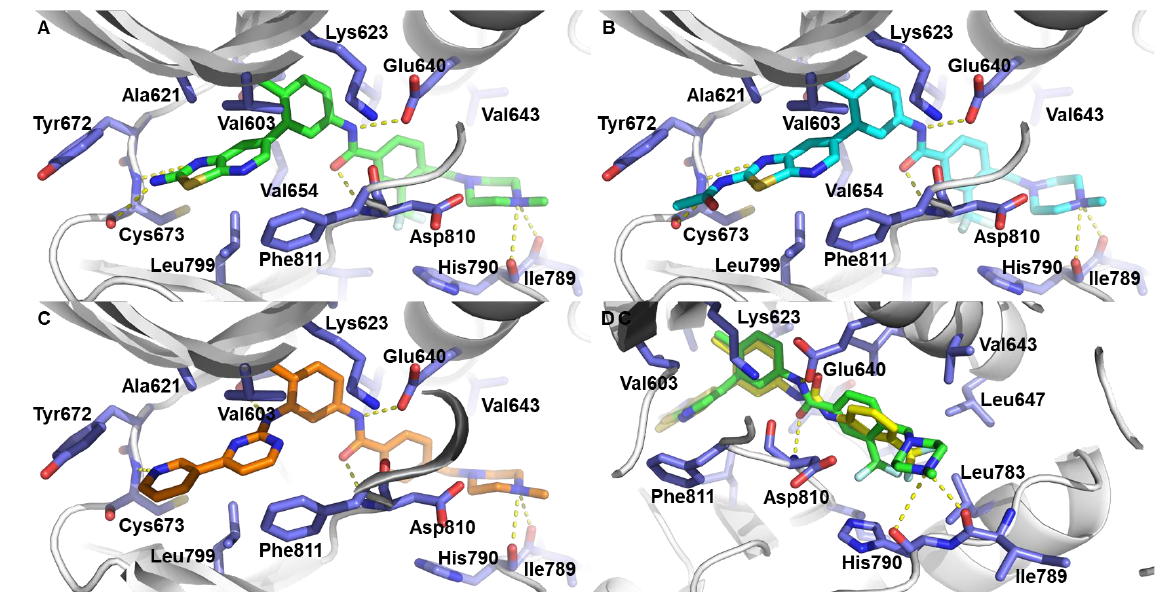
Figure 2. ( A , B ) Docking model prediction of 6r and 7c on c-KIT (PDB code: 1T46). ( C ) Binding mode of imatinib on c-KIT (PDB code: 1T46). ( D ) Superimposition with docking model of 6r and 6j . Protein residues of c-KIT are represented by white cartoon and violet stick. The 6j , 6r , 7c , and imatinib are depicted in yellow, green, cyan, and orange, respectively.